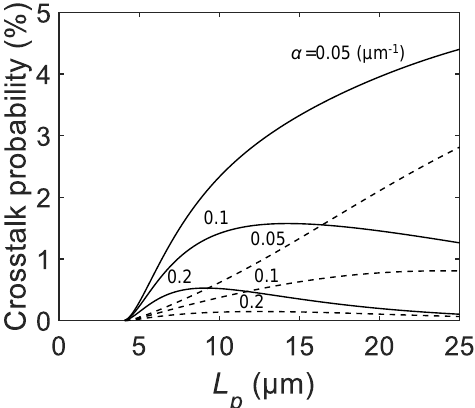
Figure 8. The calculated crosstalk probability as a function of the SPAD pixel pitch L p for C 0 = 5 fF (dashed lines) and 30 fF (solid lines), active-to-active distance L a − a = 3 µ m, B (cid:48) = 4 × 10 12 F − 1 , W ef f = 1 µ m, r in = 0.5 µ m, and α = 0.05, 0.1, and 0.2 µ m − 1